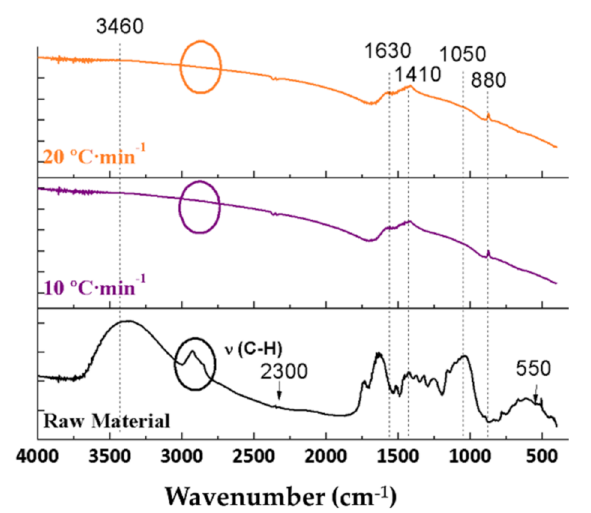
Figure 5. IR spectra of the raw materials and the biochars resulting from the pyrolyses of orange waste ( A ) and orange pruning ( B ) performed at 400 ◦ C for 2 h under 150 mL Ar · min − 1 flow rate using different heating ramps.